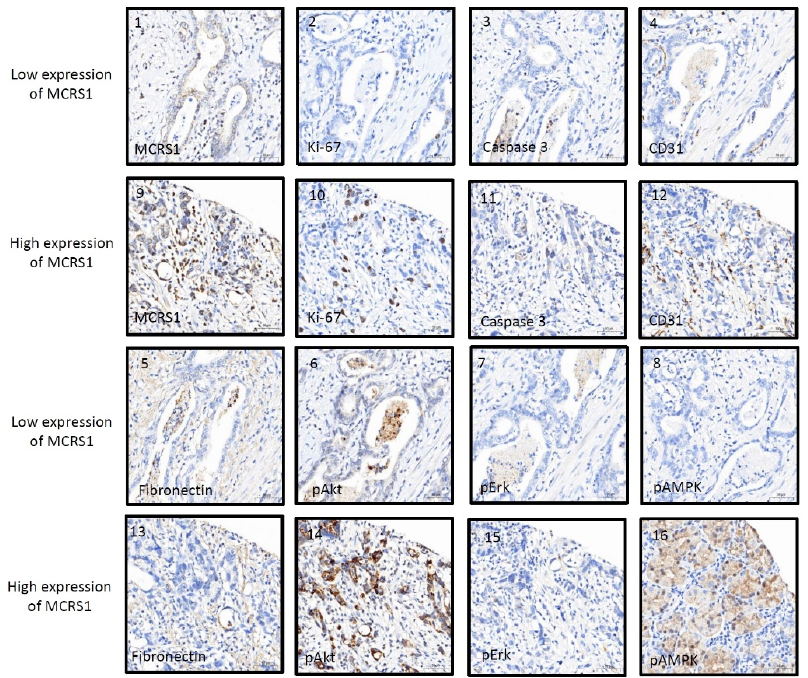
Figure 4. Immunostaining images of high or low expression levels of MCRS1 and related tumor- igenic proteins. (1–8) Low MCRS1 expression levels. (9–16) High MCRS1 expression levels.